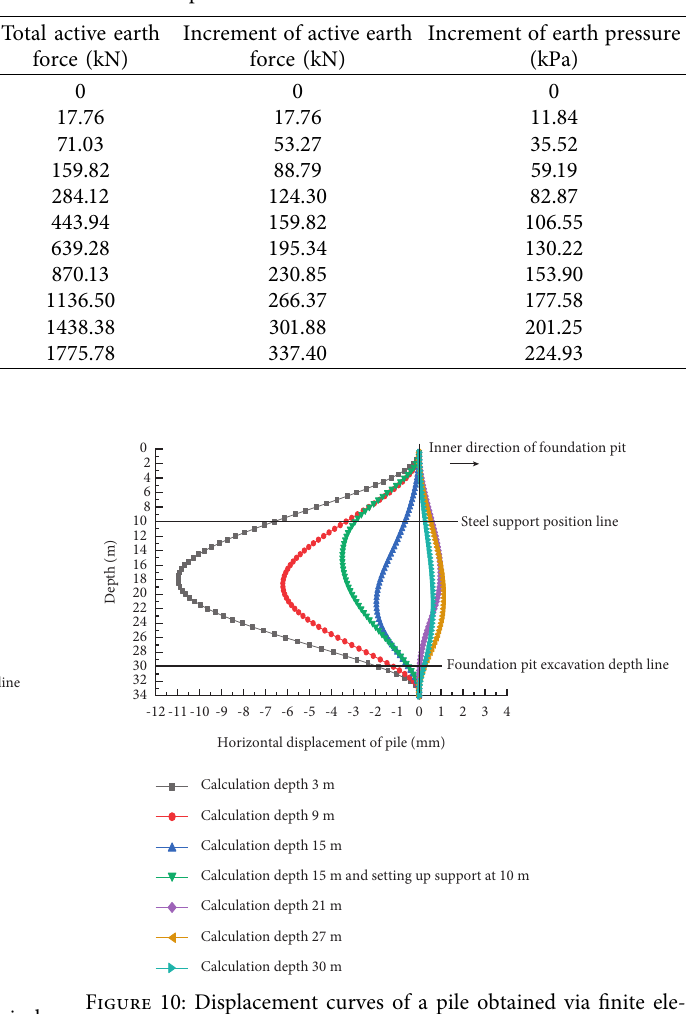
Figure 9: Displacement curves of a pile obtained via numerical calculations (incremental method).